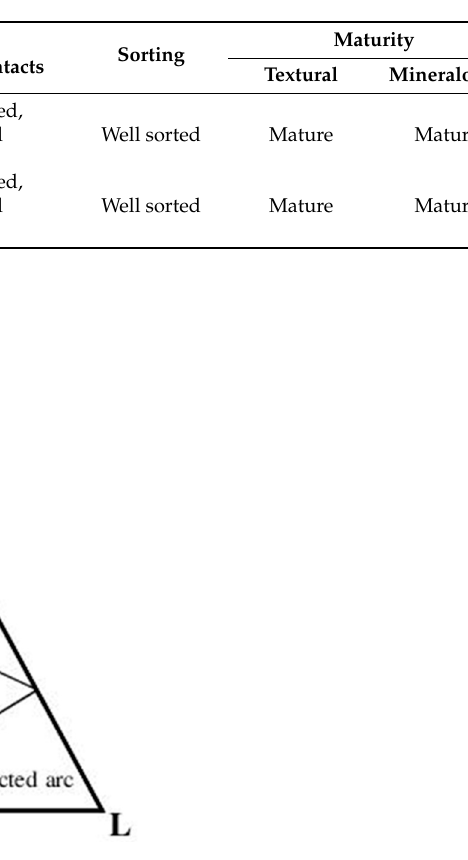
Table 2. The petrographic properties of the grains observed in thin sections.